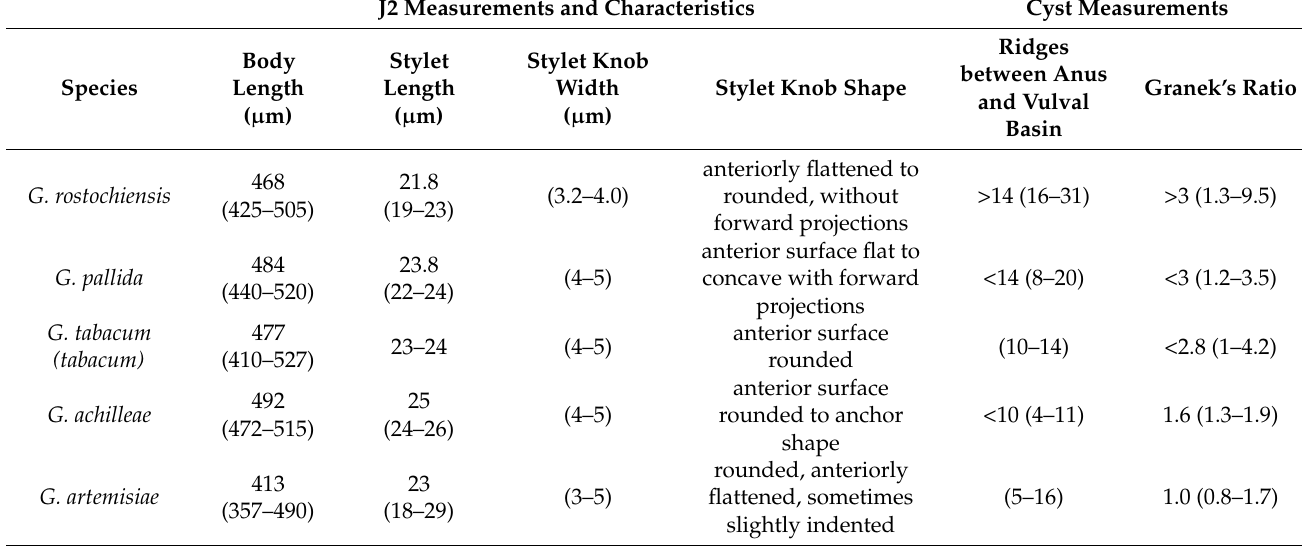
Table 3. Mean and range (in parentheses) values of some essential characters of Globodera rostochiensis , G. pallida , G. tabacum (tabacum) , G. achilleae , and G. artemisiae, as given in Baldwin and Mundo-Ocampo [56], Brzeski [57], Fleming and Powers [67], Manduric et al. [68], and Dobosz et al. [69]. J2 Measurements and